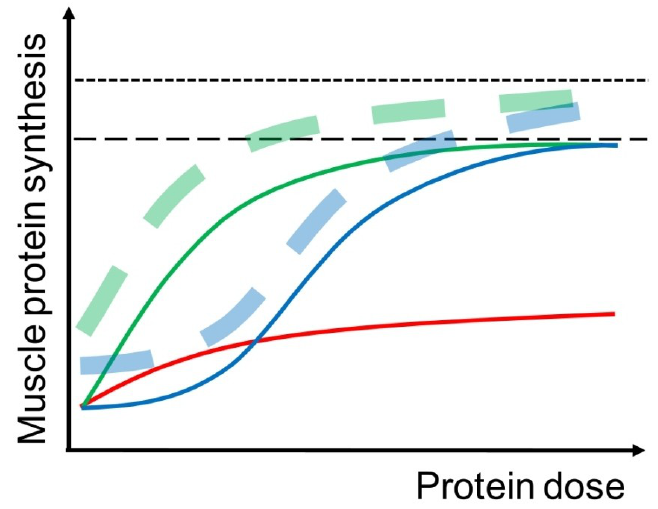
Figure 2. Illustration of the muscle protein synthetic (MPS) response to protein intake at rest (solid curves) and with prior completion of resistance exercise (dashed curves) in young (green curves) and elderly (blue curves) individuals. In the young, MPS is stimulated already at small doses (~5 g) of protein intake and the response reaches a plateau at approximately 20 g of protein intake. In the elderly, a higher amount of protein intake is necessary to simulate MPS and to obtain the maximal MPS response. The MPS response to protein intake can be enhanced by prior completion of resistance exercise, although the effect of resistance exercise is somewhat reduced in elderly compared to young individuals. Furthermore, the red curve illustrates that the MPS response to protein intake is reduced in immobilized